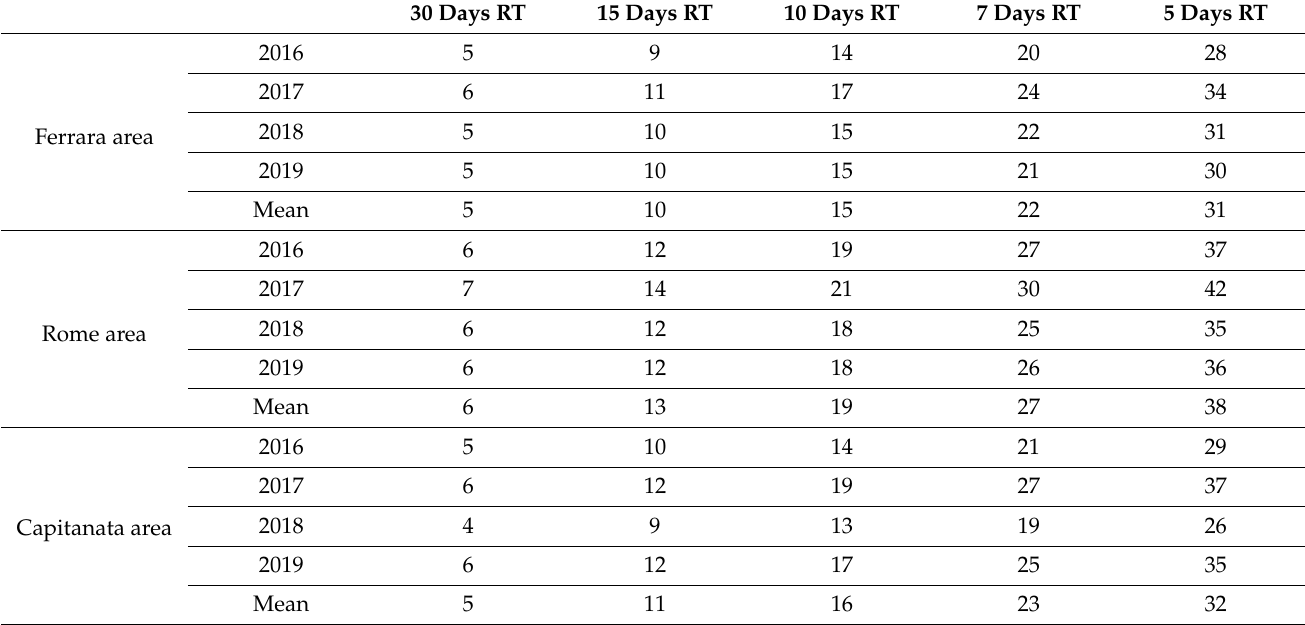
Table 5. Total number of yearly available cloud-free images expected as a function of satellite revisit time (RT) for the three areas Ferrara, Capitanata, and Rome.